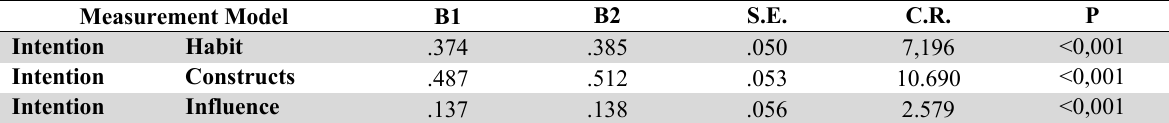
Analysis Results for Structural Model 1